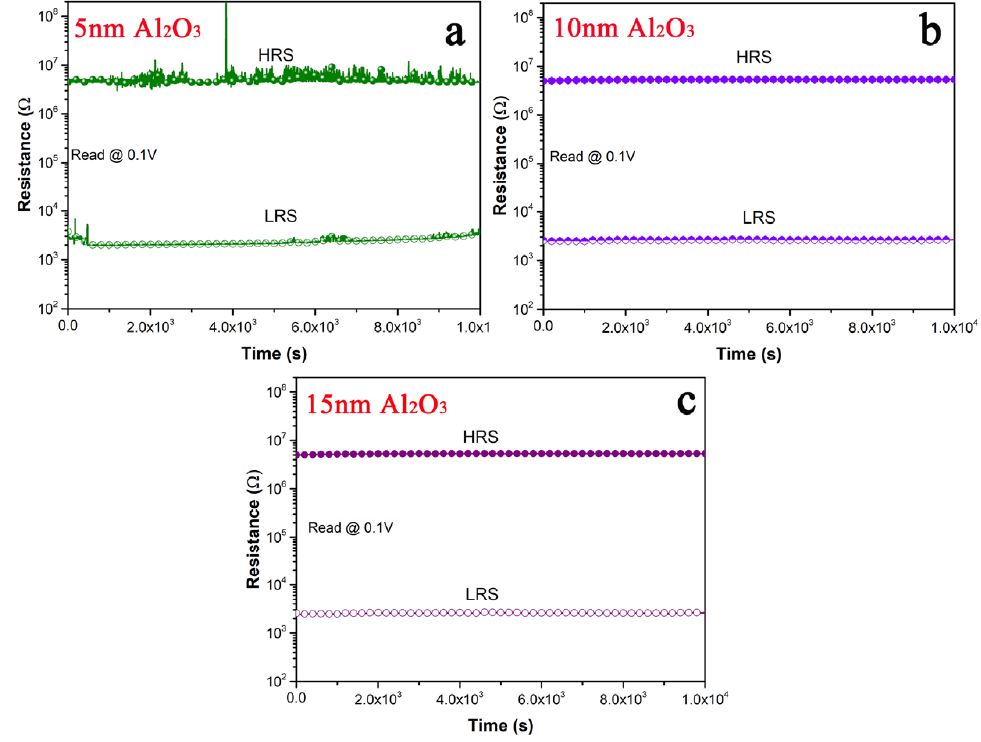
Figure 3. The retention of devices with 5 nm ( a ), 10 nm ( b ), and 15 nm ( c ) Al 2 O 3 .